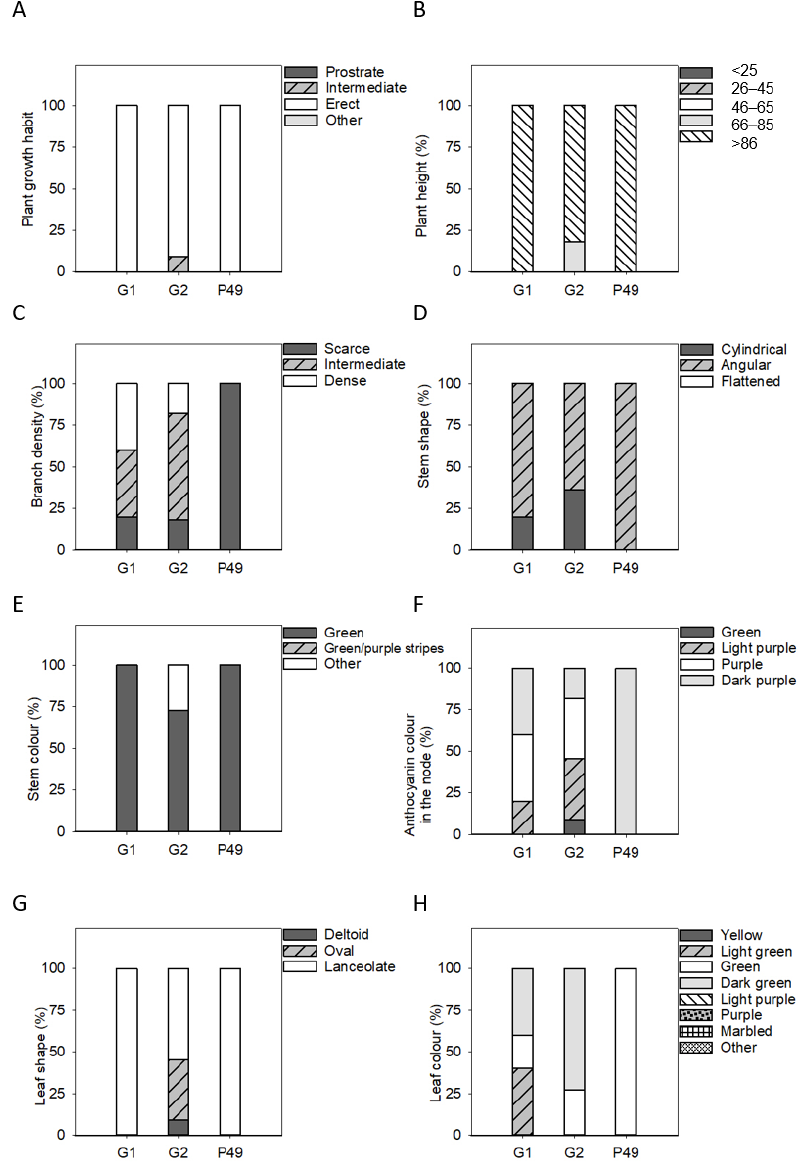
Figure 2. Frequency distribution of the plant, stem, and leaf qualitative traits in 17 pepper land- races.( A ) Plant growth habit; ( B ) Plant height; ( C ) Branch density; ( D ) Stem shape; ( E ) Stem colour; ( F ) Anthocyanin colour in the node; ( G ) Leaf shape; ( H ) Leaf colour. The mean value for each land- race was represented by the most frequent representation of the trait after classifying the independ- ent plant samples ( n = 8) according to the scale (Table S1).